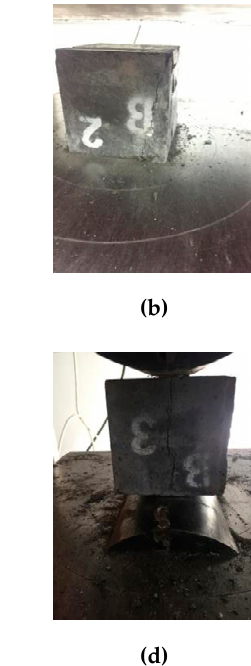
Figure 8. Influence of steel fiber on the mechanical properties of RPC: ( a ) compressive damage without steel fiber; ( b ) compressive damage with steel fiber; ( c ) split tensile failure without steel fiber; ( d ) split tensile failure with steel fiber.